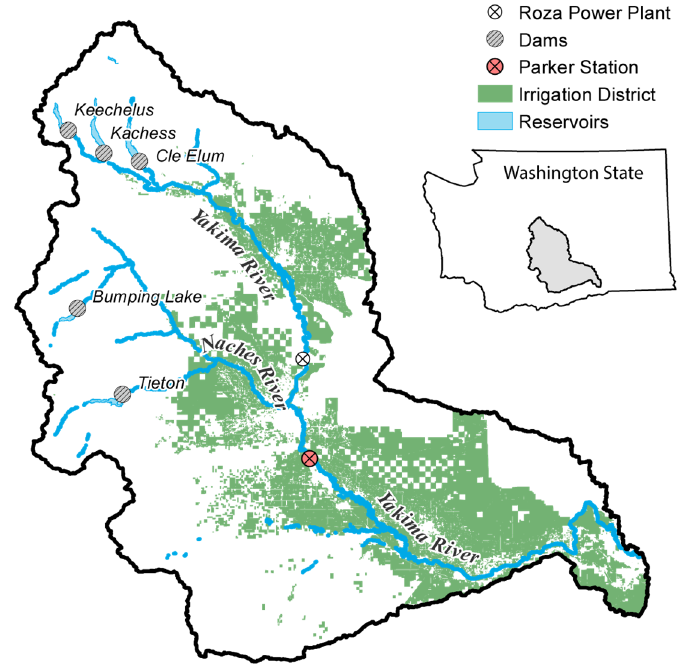
Figure 1. Locations of reservoirs, irrigation districts, Roza hydropower plant, and control point (Parker station) in the Yakima River Basin.